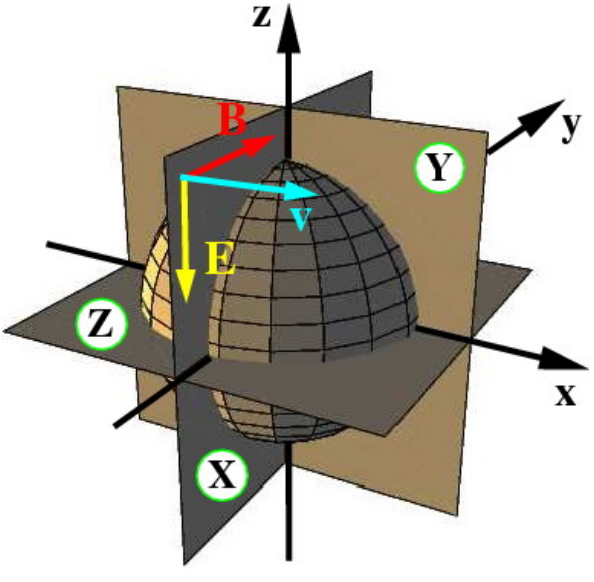
Fig. 3. Coordinate system of the three-dimensional simulation. The electric field E , the magnetic field B and the solar wind velocity v correspond to the undisturbed solar wind conditions. In Sect. 3 we discuss contour plots through the x = 0 (terminator), the y = 0 (polar) and the z = 0 (ecliptic)